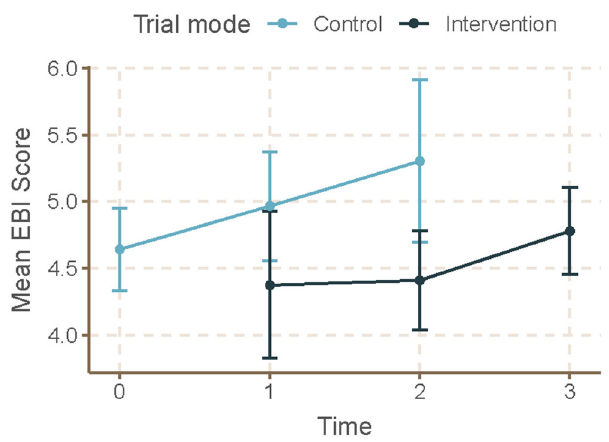
FIGURE 4 | Mean EBI score by time and trial mode. At each time point, mean and 95% confidence intervals for evidence-based interventions (EBI) score are displayed for individuals during control and intervention phases. For EBI Score, participants selected from a list of eight evidence-based programs or policies related to chronic disease prevention which were currently implemented at their respective local health department. We summed all 8 possible EBIs to calculate the EBI score which had a possible range of 0–8. Time 0 represents baseline where all units (local health departments) were in control period. Time 3 is the final data collection point and all individuals are in intervention period. Total mean skill gap score was created as an average of the 10 individual competency